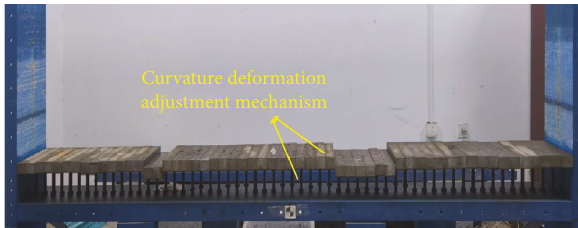
Figure 6: Similarity simulation experimental device.